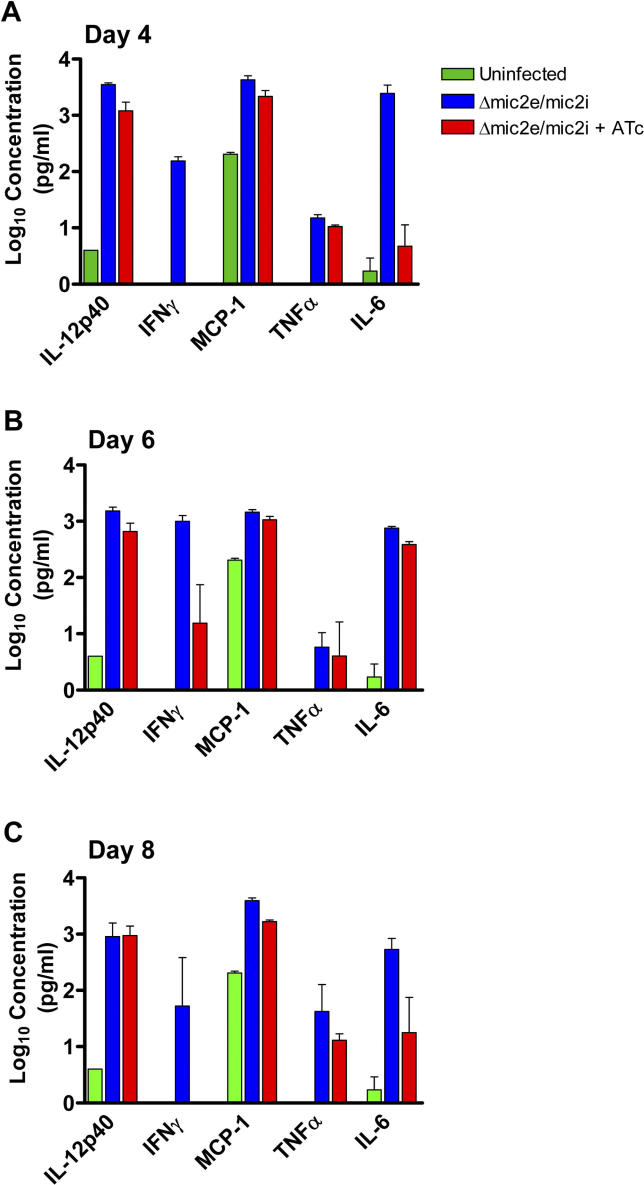
Mice Infected with MIC2-Deficient Parasites Produce Lower Levels of Inflammatory CytokinesMice were infected with Δmic2e/mic2i ± ATc and treated with or without ATc in drinking water. Serum was collected from three mice on days 4 (A), 6 (B), and 8 (C) post-infection. Cytokine levels were determined by a quantitative cytokine protein microarray analysis.